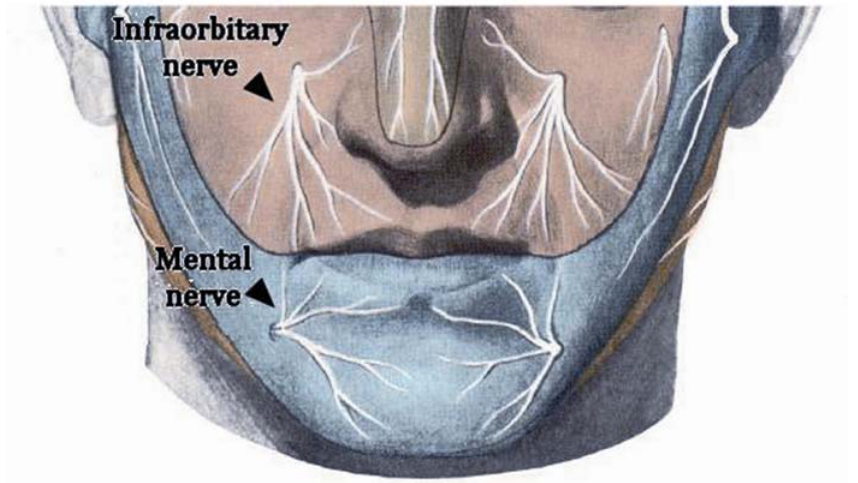
FIGURE 2 . Distribution of fibers of infraorbitary and mental nerves (sensory branches of trigeminal nerve). (Figure from Balboni GC et al ., Anatomia Umana , vol. 3, 3rd ed, Ed. Ermes, Milan, 1990. Modified with